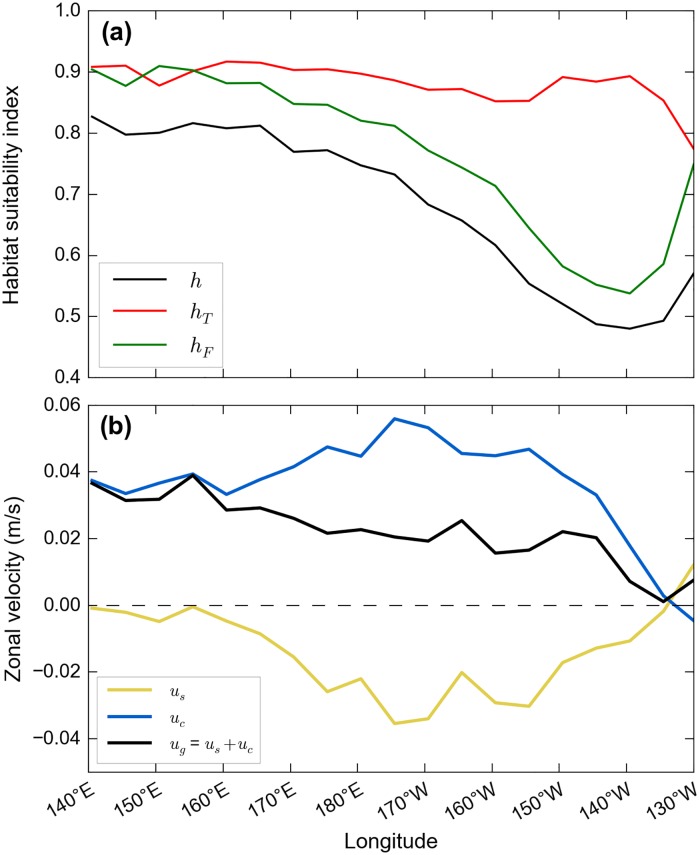
Zonal variations in habitats and speeds.Averaged longitudinal variations of (a) habitat suitability indices (h, hT, hF) and (b) zonal speeds (us, uc, ug) along the trajectories of active turtles crossing the North Pacific.